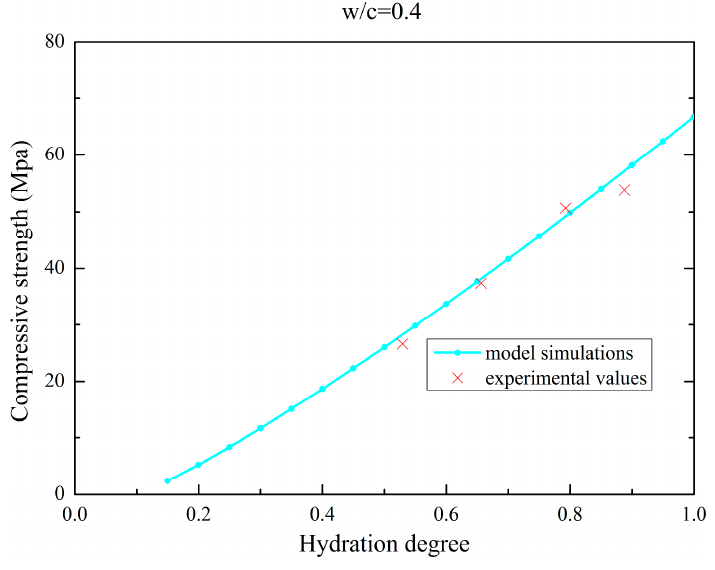
Figure 8. Compressive strength evolution for isothermal test of SSC (w/c = 0.40).